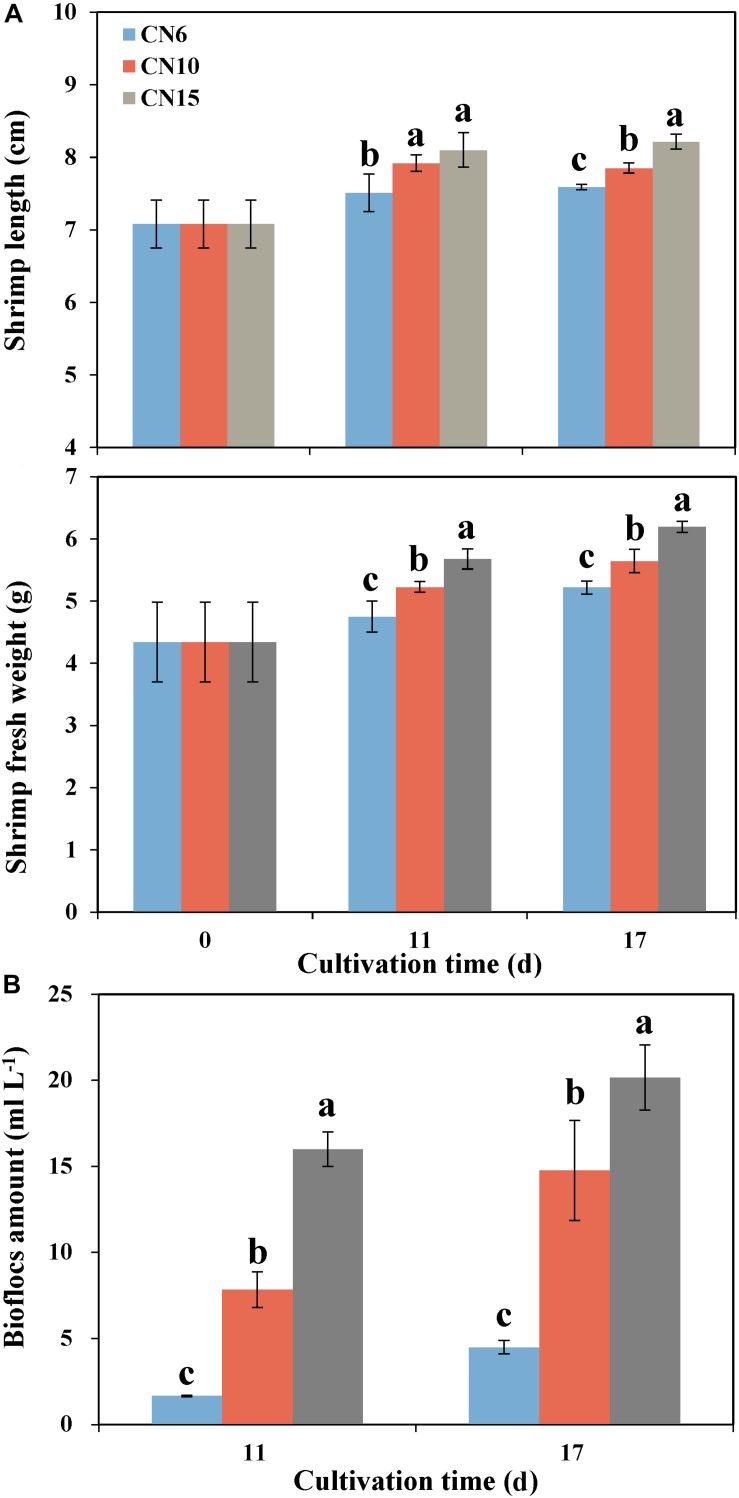
The length and weight of shrimp individuals (A) and bioflocs (B) volume in different experiment groups (CN6, CN10, and CN15) after 11 and 17 days of experiment. Data present means ± deviation (n = 10). Different lowercase letters on the histogram indicate significant difference (one-way ANOVA, P < 0.05).